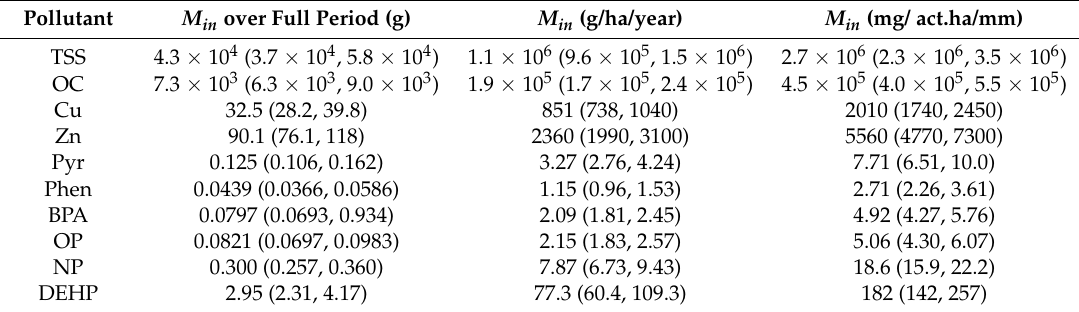
Table 3. Summary of pollutant loads in road runoff, median and 95% confidence